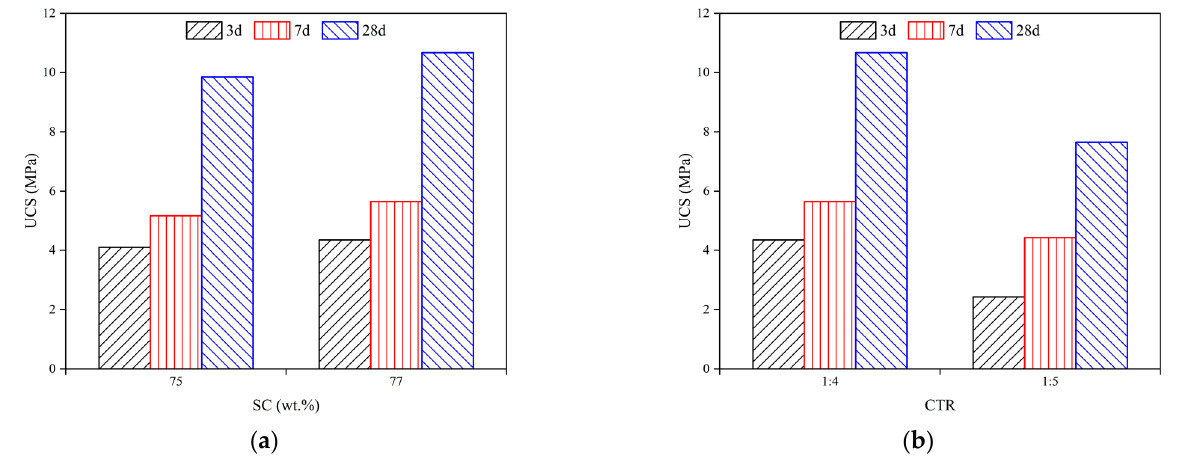
Figure 12. Relationship between the SC and the UCS of the FCPB (FC = 5%): ( a ) CTR = 1:4 and ( b ) SC = 77 wt.%.